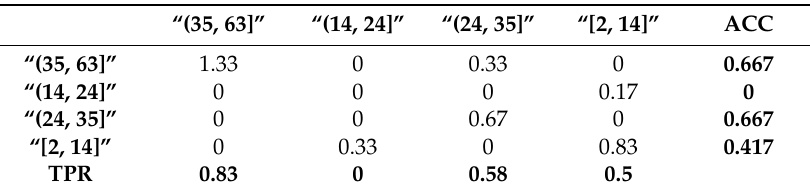
Table 12. Confusion matrix for UPDRS III model. Classification accuracy 81.7%, 61.1% coverage, 40 examination records. Test method: six-fold cross validation.